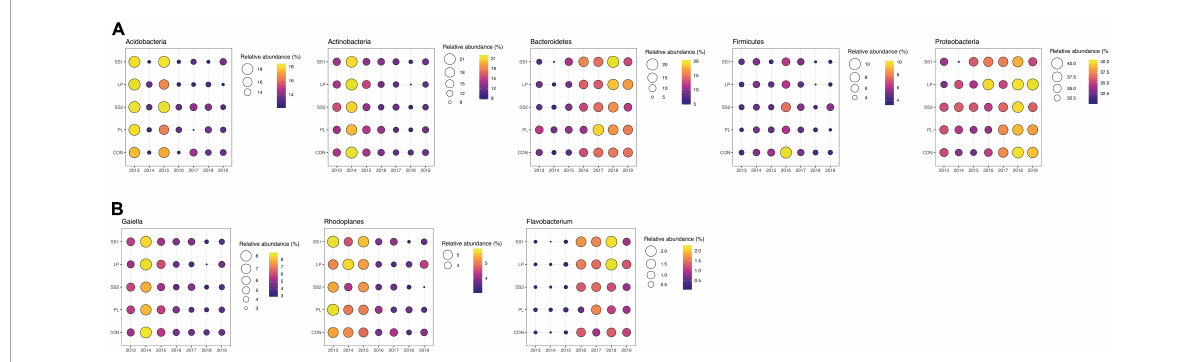
FIGURE6 Bubble plots showing the relative abundance of the major bacterial phyla (A) and genera (B) significantly different depending on fertilization practices (CON, inorganic fertilizer control; SS1 and SS2, sewage sludge inputs; LP, liquid pig manure; PL, poultry litter) over time after a LEfSe analysis. Presented phyla and genera were selected based on LEfSe analysis allowing to detect the taxa with significant differential abundances among the soil fertilization types for all years.